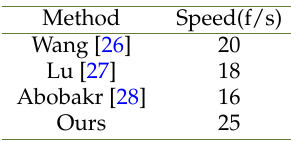
Table 4. Detection speed of different methods.